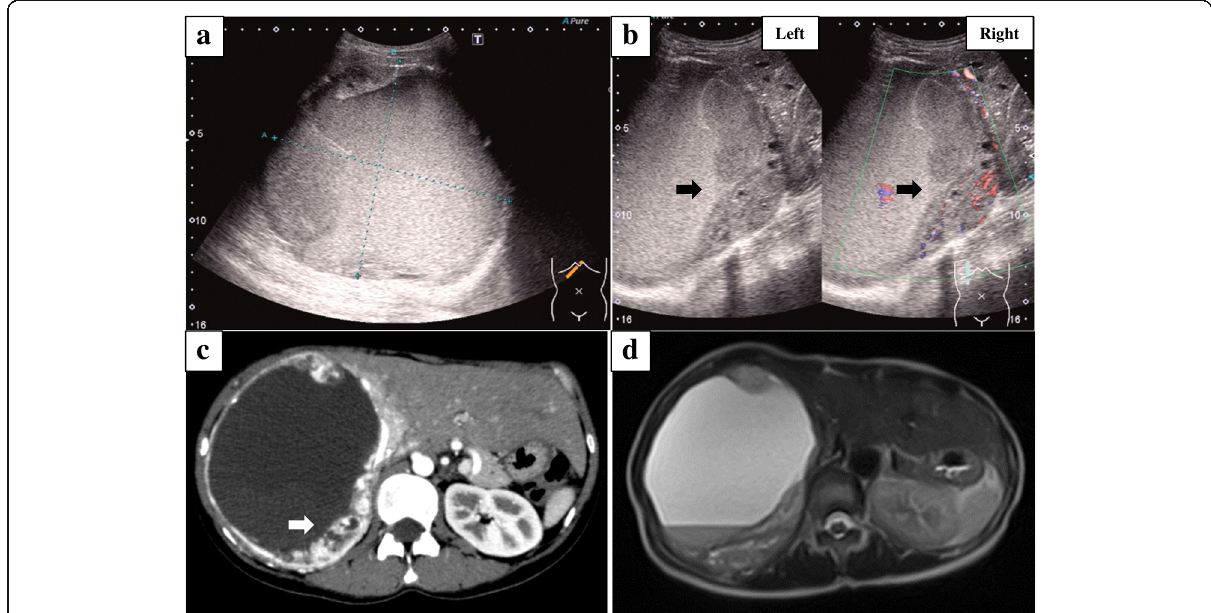
Fig. 1 Findings from abdominal ultrasonography, CT, and MRI. a Abdominal ultrasonography shows an extensive space-occupying lesion in the right lobe of the liver, 15 cm in diameter. b Left photo shows a mural nodule, and right photo shows a heterogeneous internal component including hemorrhage and hypervascularity ( black arrow ). c Abdominal contrast-enhanced computed tomography shows a cystic mass measuring 13×14×11 cm in the right lobe of the liver with an enhanced mural nodule ( white arrow ). d Abdominal magnetic resonance imaging (MRI) shows a hyperintense component on T2-weighted imaging compatible with the hemorrhagic